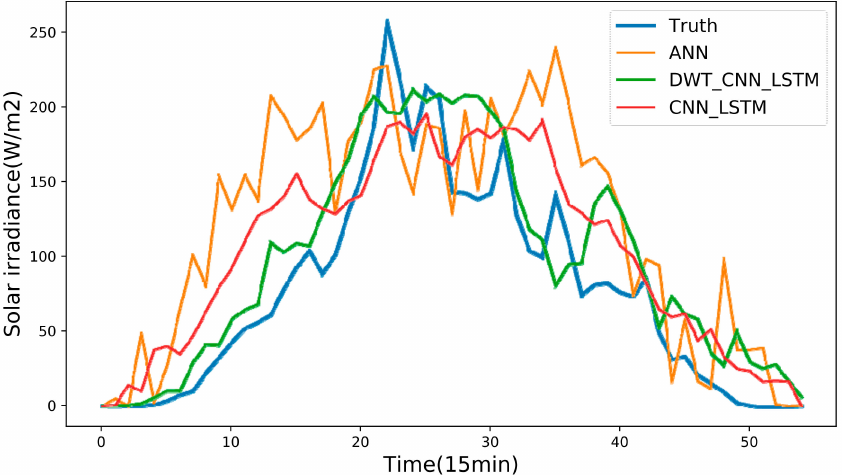
Figure 10. Actual and forecasted solar irradiance on heavy rainy day pattern using dataset of Elizabeth City State